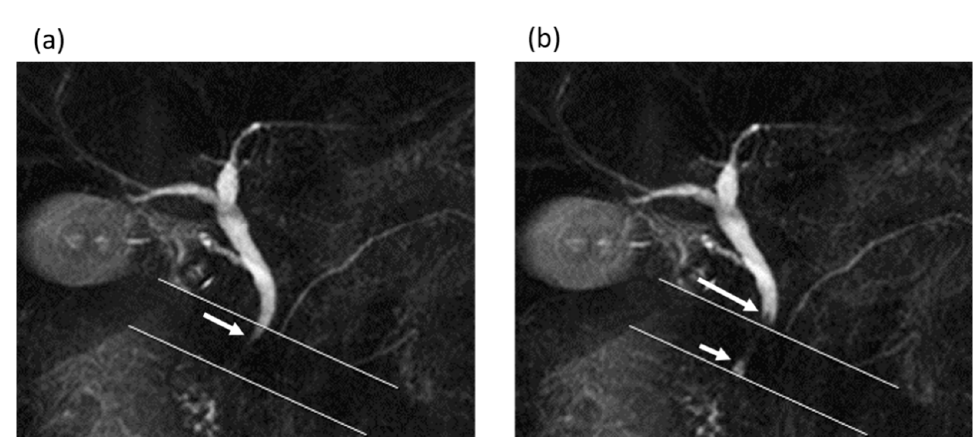
Figure 4. A 75-year-old man in the gallstone group. ( a , b ) Cine-dynamic MRCP images with a spatially selective IR pulse. ( a ) The antegrade bile flow was shown as high signal intensity (arrow) within the area of the IR pulse, showing a grading score of 4. ( b ) The reverse bile flow was seen as low signal intensity outside the area of the IR pulse (long arrow) and was also observed as high signal intensity coming from duodenal papilla side into the area of the IR pulse (short arrow). The grading score of reverse bile flow was categorized as 2. In the gallstone group, the frequency and mean secretion grade of the antegrade bile flow showed no significant correlations with the common bile duct diameter (frequency, r = − 0.164, p = 0.433; mean secretion grade, r = − 0.099, p = 0.638), the SIR of the gallbladder in T1-weighted in-phase imaging (frequency, r = 0.194, p = 0.353; mean secretion grade, r = 0.192, p = 0.358), or the SIR of the gallbladder in T1-weighted opposed-phase imaging (frequency, r = 0.209, p = 0.316; mean secretion grade, r = 0.135, p = 0.519) (Table 2). In the non-gallstone group, the frequency and mean secretion grade of the antegrade bile flow also showed no significant correlations with the common bile duct diameter (frequency, r = 0.065, p = 0.593; mean secretion grade, r = 0.061, p = 0.619), the SIR of the gallbladder in T1-weighted in-phase imaging (frequency, r = − 0.146, p = 0.232; mean secretion grade, r = − 0.134, p = 0.273), or the SIR of the gallbladder in T1-weighted opposed-phase imaging (frequency, r = − 0.097, p = 0.428; mean secretion grade, r = − 0.092, p = 0.450) (Table 2).